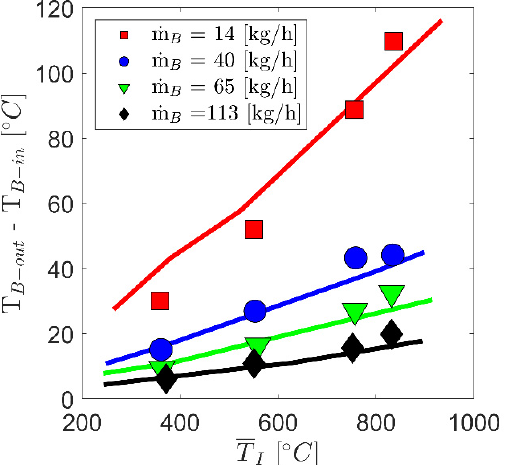
Figure 6. Steady-state bypass temperature differences between outlet (T B − out ) and inlet (T B − in ) as Figure 6. steady-state bypass temperature differences between outlet ( T (cid:3003)(cid:2879)(cid:3042)(cid:3048)(cid:3047) ) and inlet ( T (cid:3003)(cid:2879)(cid:3036)(cid:3041) ) as a function of average inventory temperatures ( T(cid:3365) (cid:3010) )—experimental results illustrated with symbols, a function of average inventory temperatures (T I )—experimental results illustrated with symbols, simulative results with lines. simulative results with